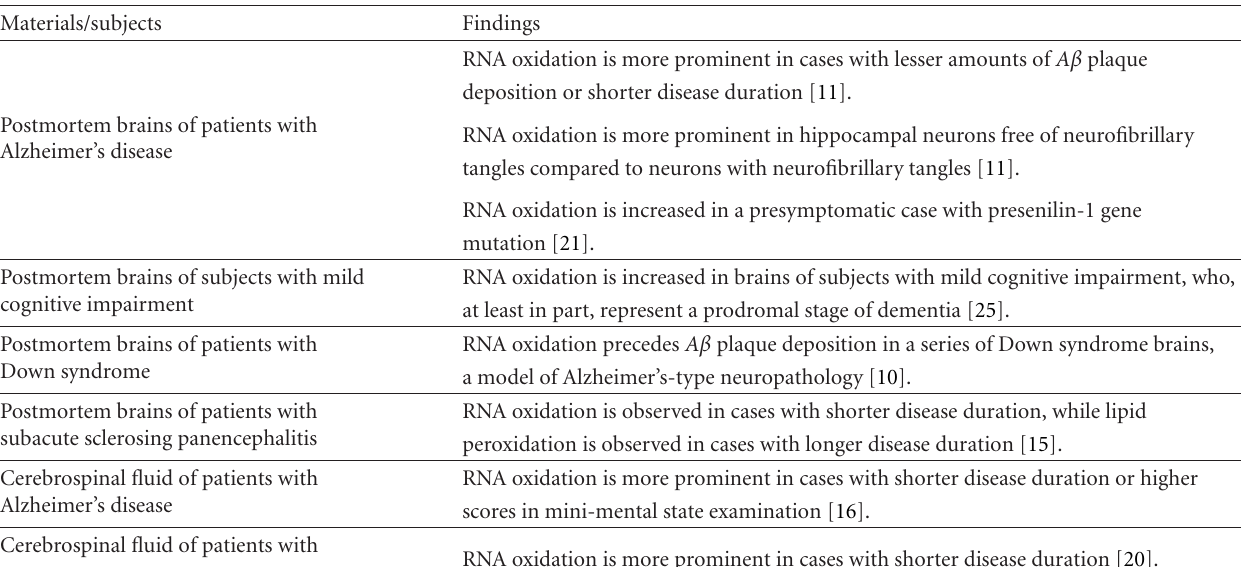
Table 2: Summary of evidence suggesting temporal primacy of RNA oxidation in the process of